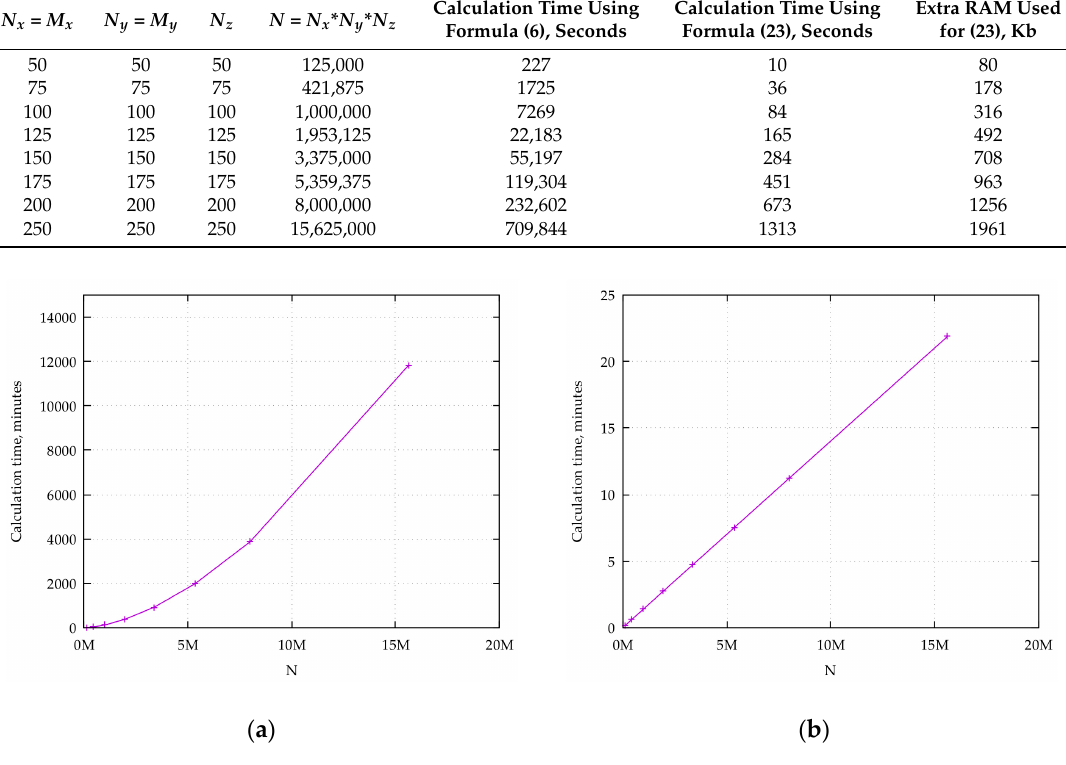
Figure 2. Dependence of calculation time on the partitioning elements count. ( a ) without optimizations—using formula (6); ( b ) with optimizations—using formula (23).